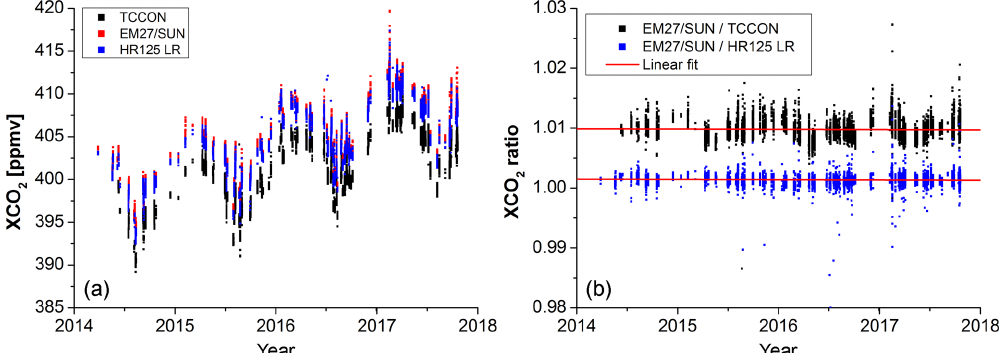
Figure 4. (a) shows the XCO 2 time series measured at KIT in Karlsruhe for the three data sets from March 2014 to October 2017. For clarity, only coincident measurements (within 1min) of the data sets are plotted. (b) shows the XCO 2 ratio between the EM27/SUN and the two HR125 data sets. A linear fit was applied to investigate a possible trend in the